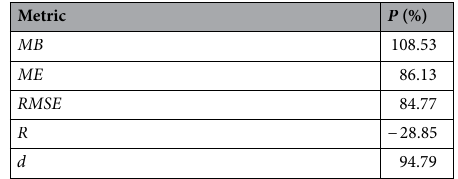
Table 2. Average percentage improvements in ensemble-average skill scores ( P ). Percentages are shown for the Mean Bias ( MB ), Mean Error ( ME ), Root Mean Square Error ( RMSE ), Correlation Coefficient ( R ) and Index of Agreement ( d ). For full details, see Supplementary Table